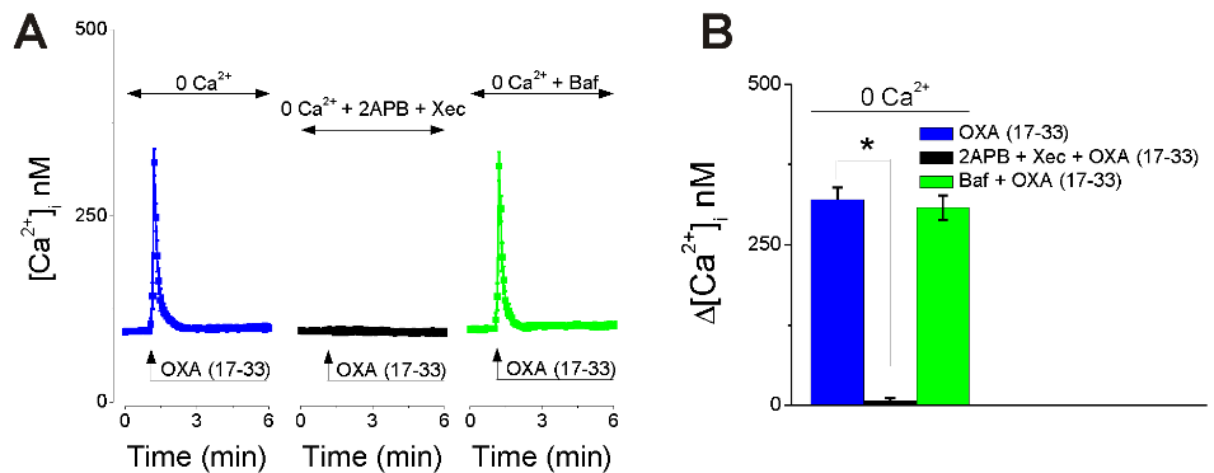
Figure 2. OXA (17-33) increases [Ca 2+ ] i via IP 3 -dependent mechanism. ( A ) Illustration of average Ca 2+ transients ( ± SD) induced in Ca 2+ -free saline by OXA (17-33) (10 nM) alone (left) and OXA (17-33) (10 nM) after pretreatment with 2-aminoethoxydiphenyl borate (2-APB, 100 µ M) and xestospongin C (XeC, 10 µ M, 15 min), IP 3 receptor antagonists (middle), or with bafilomycin A1 (Baf, 1 µ M) (right). ( B ) Comparison of the amplitude of the increase in [Ca 2+ ] i (average + SD) in each condition. Pretreatment with 2-APB and xestospongin C abolished the Ca 2+ response induced by OXA (17-33). * p < 0.05; n = 6 neurons/condition.